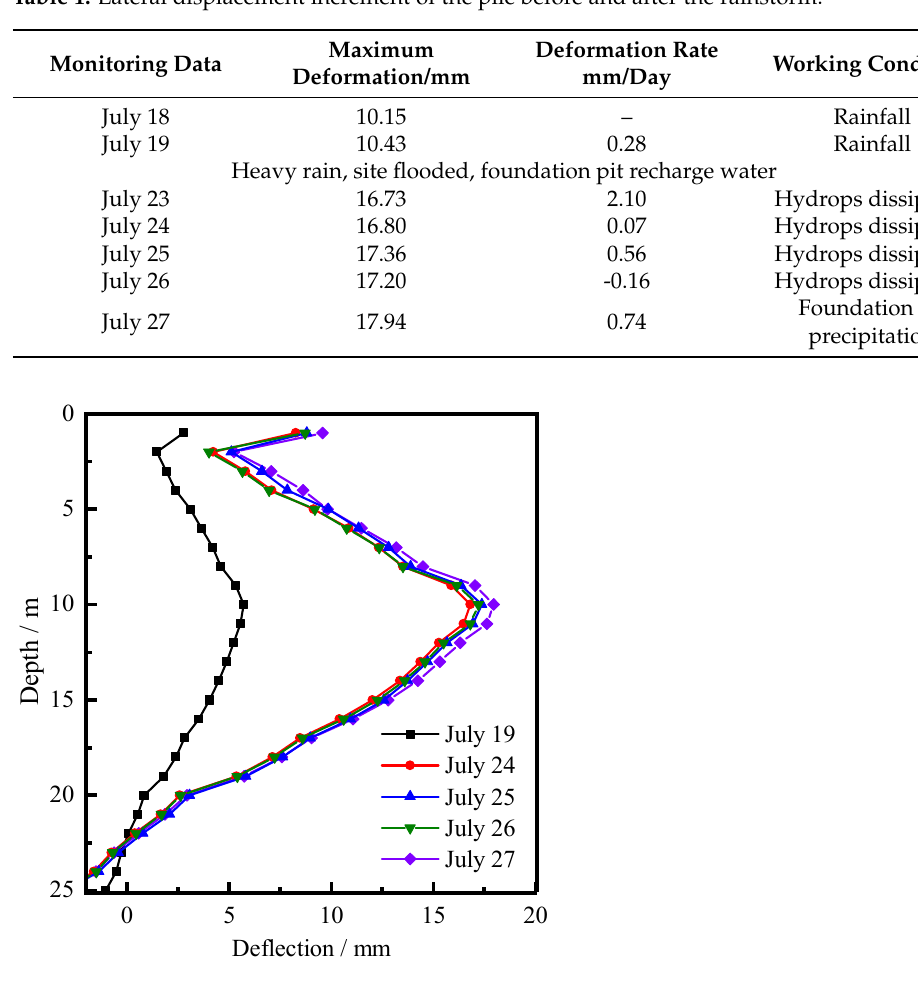
Figure 3. Lateral displacement of the pile at different times.